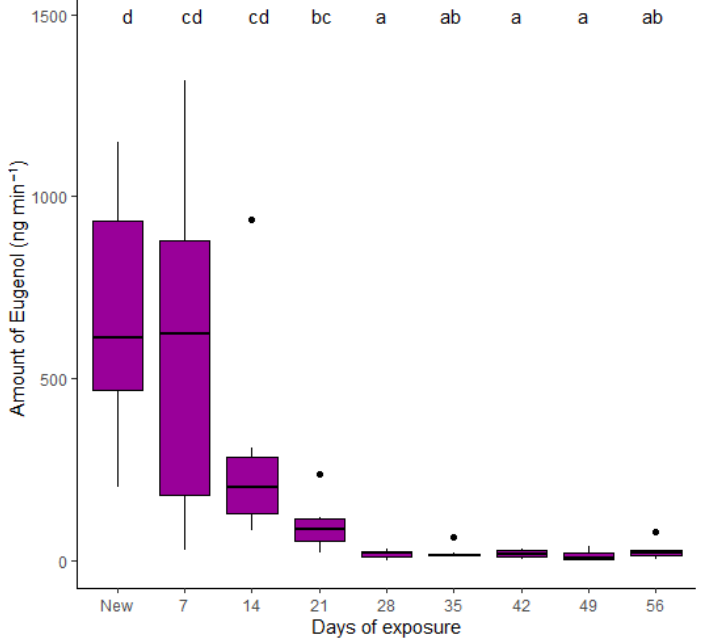
Figure 6. Statistical analysis of Cacopsylla pyri capture rates (time average from Figure 5) per trap- type (green traps equipped with blank nanofibers or green traps equipped with M6-loaded nanofibers) in field experiment using the Tukey test. The same letters (generalized linear model, Tukey test, p < 0.05) indicate no significant differences. Boxes correspond to the 25th and 75th percentiles, medians appear as lines, and whiskers extend to 1.5 times of the interquartile ranges. Dots represent raw values. Dots with crosses represent the means.